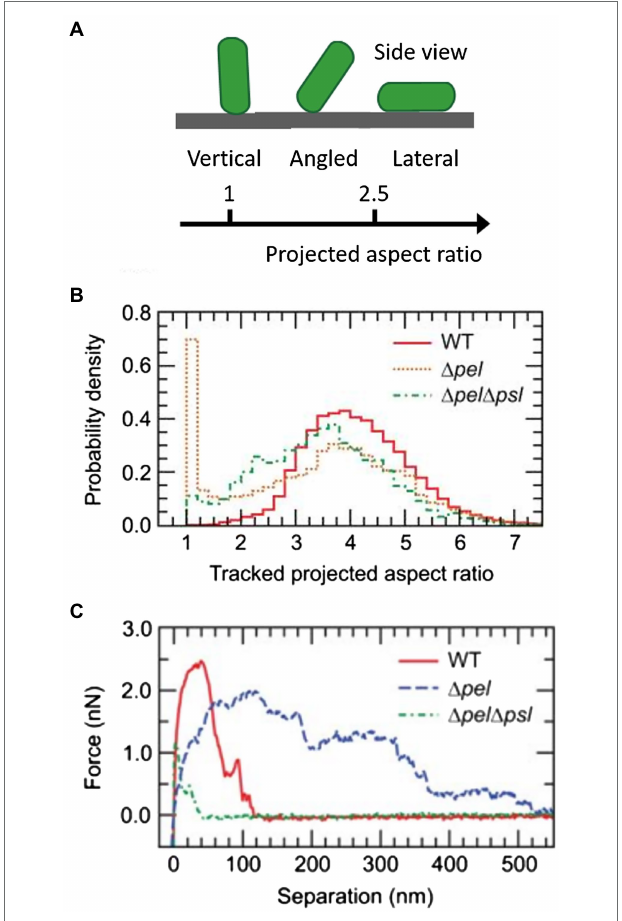
FIGURE 7 | Analysis of the initial attachment phase of P. aeruginosa . (A) Schematic representation of the cell aspect ratio in a 2D projection. (B) Normalized histograms of the projected aspect ratios of WT, Δ psl , and Δ pel Δ psl P. aeruginosa cells. The position of the main peak for the Δ pel Δ psl strain is shifted to the left of the main peak for WT and Δ psl strains, indicating that the Δ pel Δ psl cells spend more time in a configuration tilted from the surface. For Δ psl cells, a second peak near 1 appears, corresponding to bacteria standing vertically on the substrate. (C) Representative individual force curves, showing adhesive characteristics of each strain. Δ pel Δ psl has an adhesion range significantly shorter than that of WT. Δ pel has a longer range of adhesion, but the magnitude is smaller than that of WT. Panels (B,C) are adapted with permission from Cooley et al.